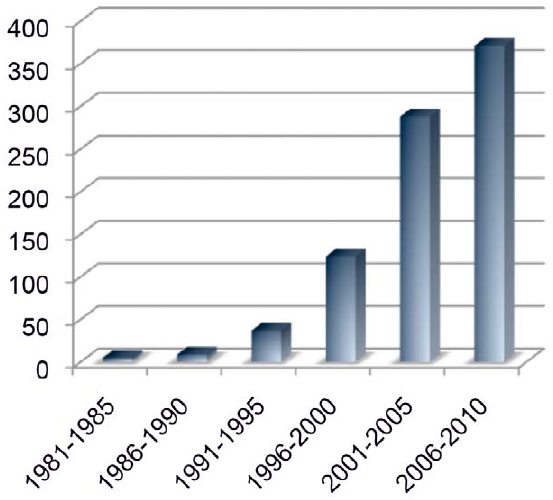
Figure 1. PubMed references to mouse modifier genes. Growing interest in and recognition of modifier genes in mouse models is supported by increased publication rates in 5-year windows for the last 30 years. Mouse modifier papers have increased at a rate faster than the increase of total PubMed citations over the past 15 years.